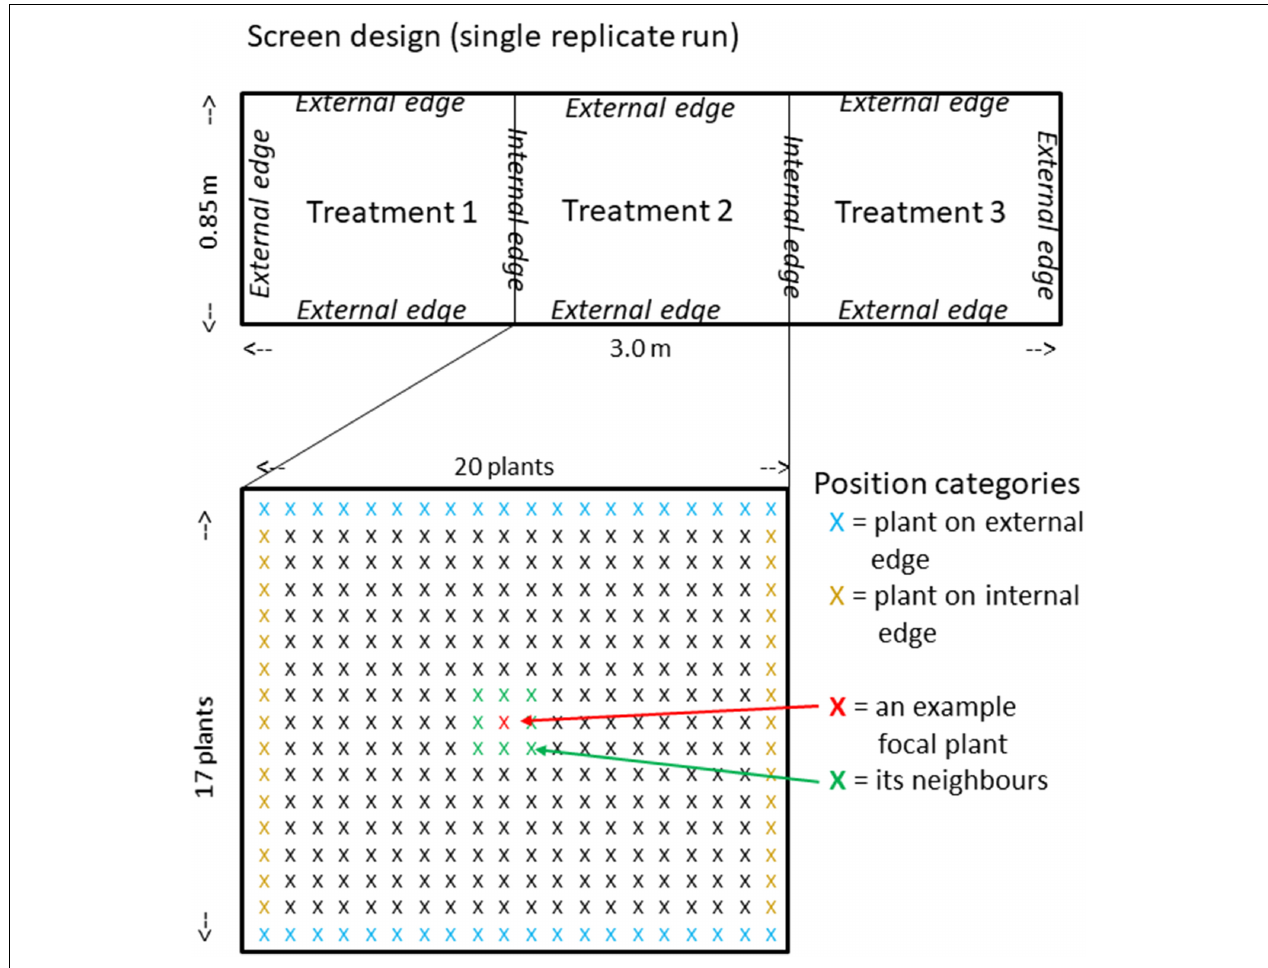
FIGURE 2 | RDP1 screen design. Above, plan of the three treatments (randomly allocated) of each replicate run showing internal and external edges. Below, expanded plan of single central treatment showing individual plants (marked with X) highlighting plants on external and internal edges, plus a graphic explanation of the meaning of neighbors in relation to a focal